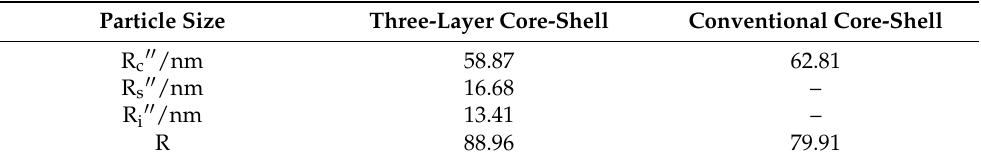
Table 3. Particle size at each stage by DLS. Particle